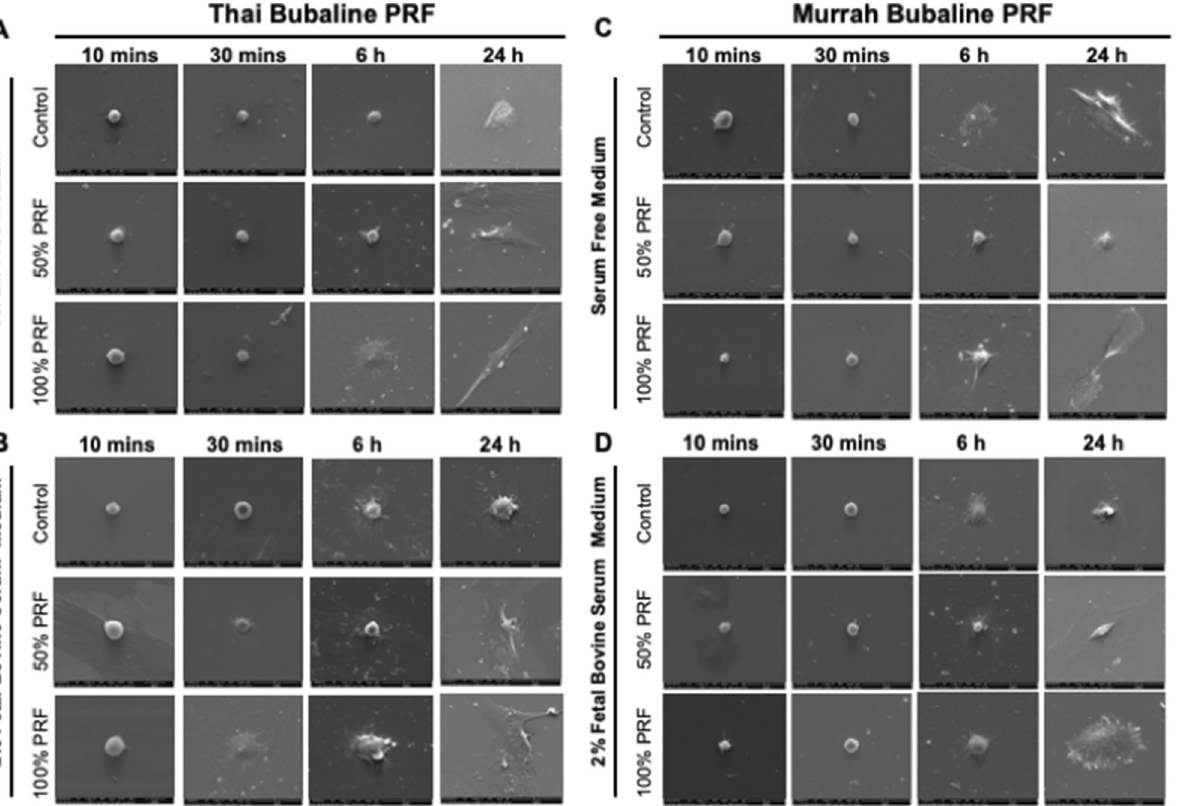
Figure 5. Bubaline blood derived platelet rich fibrin (PRF) induced cPDLs spreading. Cells were maintained in serum free ( A and C ) or 2% FBS ( B and D ) culture medium with the supplementation of 50% or 100% PRF extracts. Cell spreading at different time points (10 min, 30 min, 6 h and 24 h) was examined using scanning electron